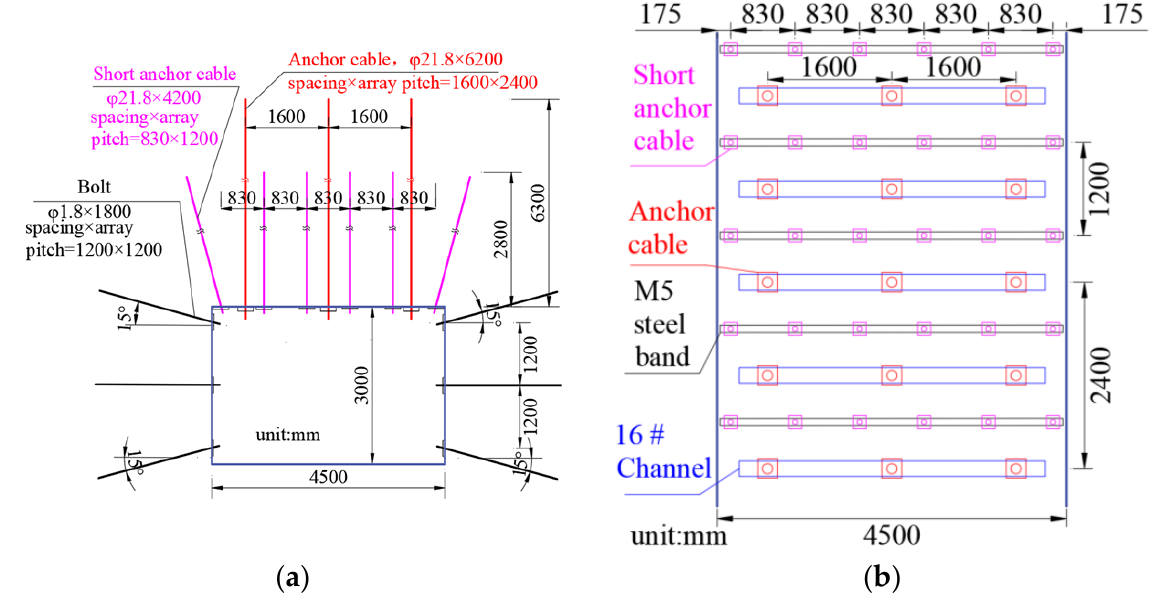
Figure 16. Roadway Support. ( a ) Roadway section support. ( b ) Roadway-roof